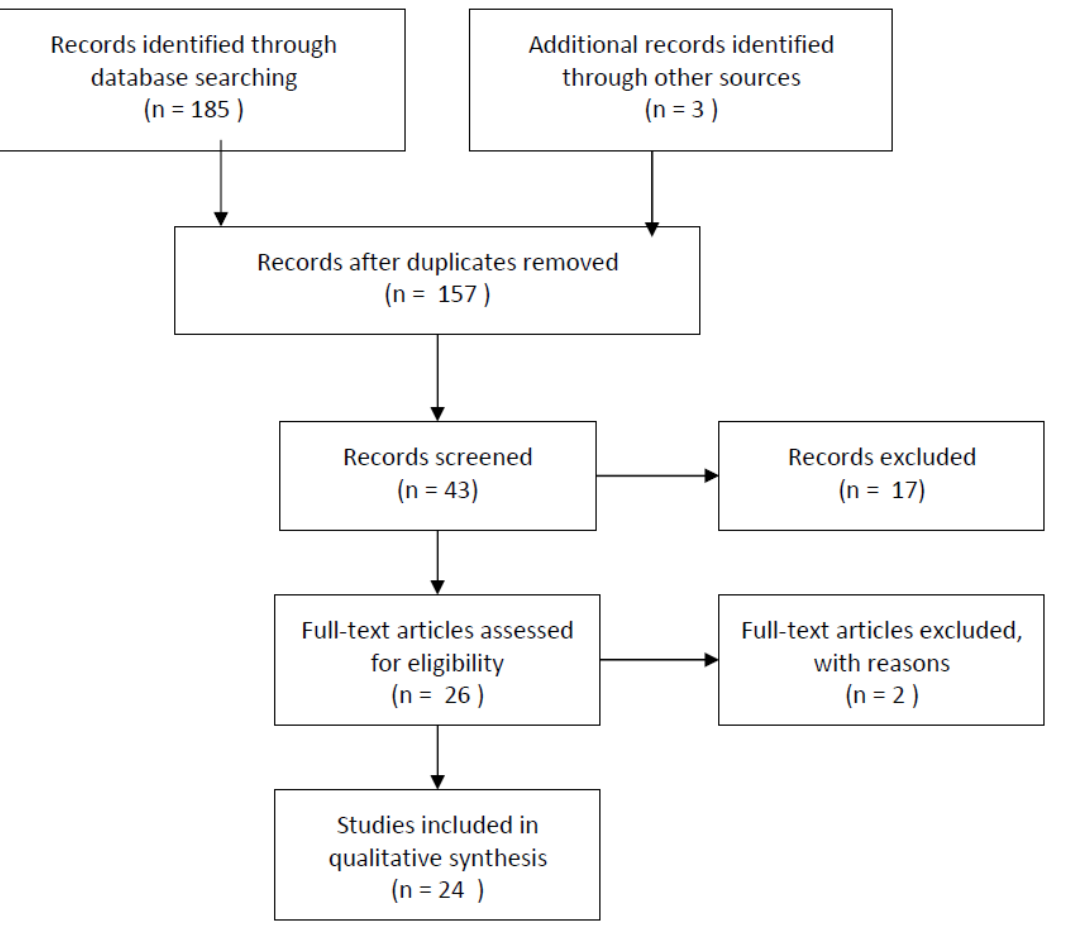
Figure 1. Flow Figure 1. Flow diagram.